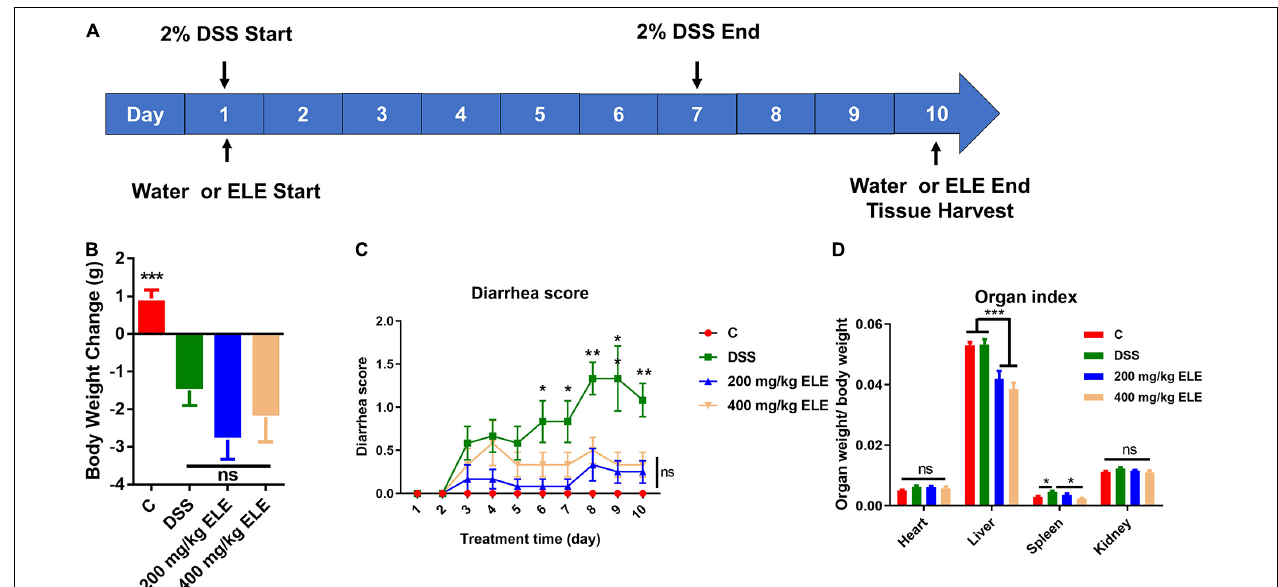
FIGURE 1 | Effects of ELE on body weight, diarrhea score, and organ index in mice. (A) The experimental process of this study. (B) Oral administration of ELE could not improve DSS-induced weight loss in mice. (C) Oral administration of ELE significantly improved DSS-induced diarrhea in mice. (D) Oral administration of ELE significantly decreased liver index and improved spleen index induced by DSS. Differences in data in mouse subjects were assessed by one-way ANOVA. n = 10–12 mice/group. * p < 0.05; ** p < 0.01; *** p < 0.001. ELE, Eucommia ulmoides leaf extract; DSS, dextran sulfate